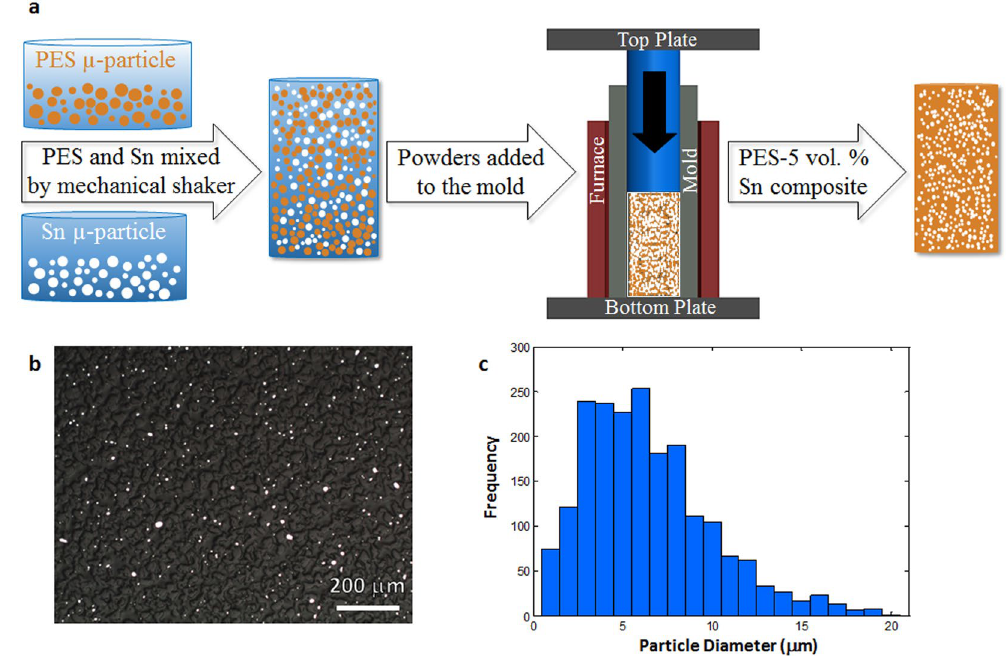
Figure 1. PES-5 Sn composite preform fabrication with poor metal distribution. ( a ) Schematic of the thermal consolidation process. ( b ) A typical optical microscope image from the longitudinal cross-section of a PES-5 Sn composite perform (scale bar: 40 μ m). ( c ) Sn microparticles size distribution in a PES-5 Sn composite